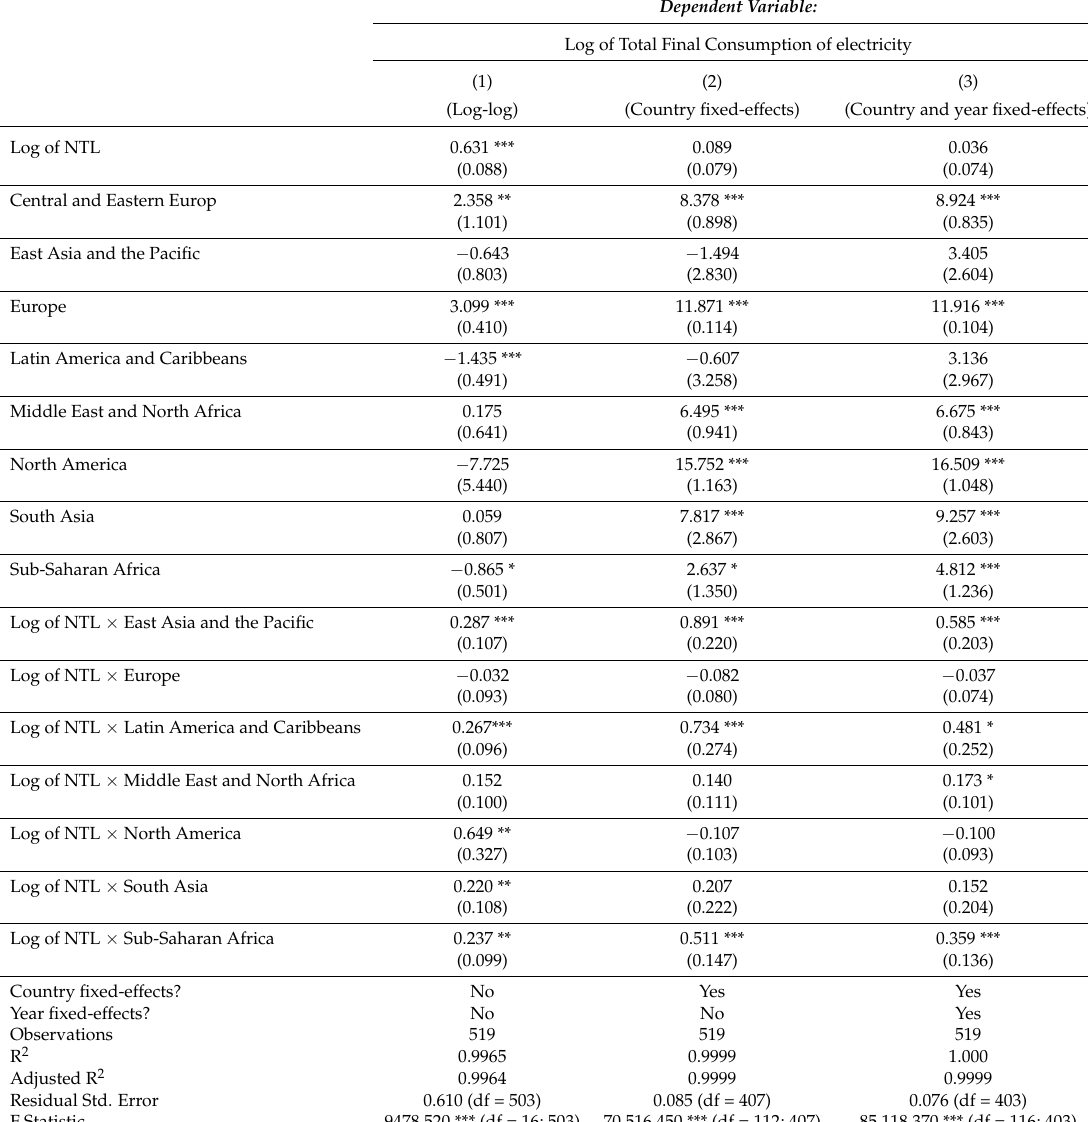
Table A10. Regression for RESIDENT—regional